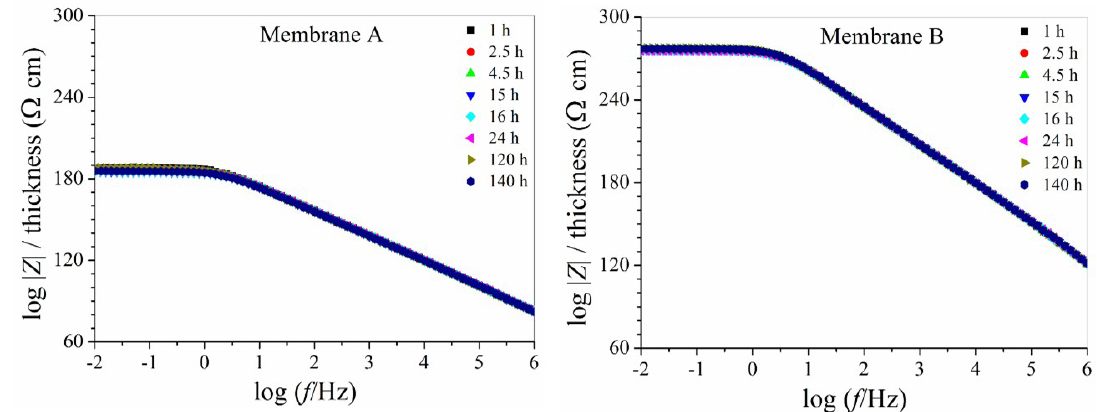
Figure 8. Impedance modulus | Z | / thickness versus frequency for membrane A and membrane B .